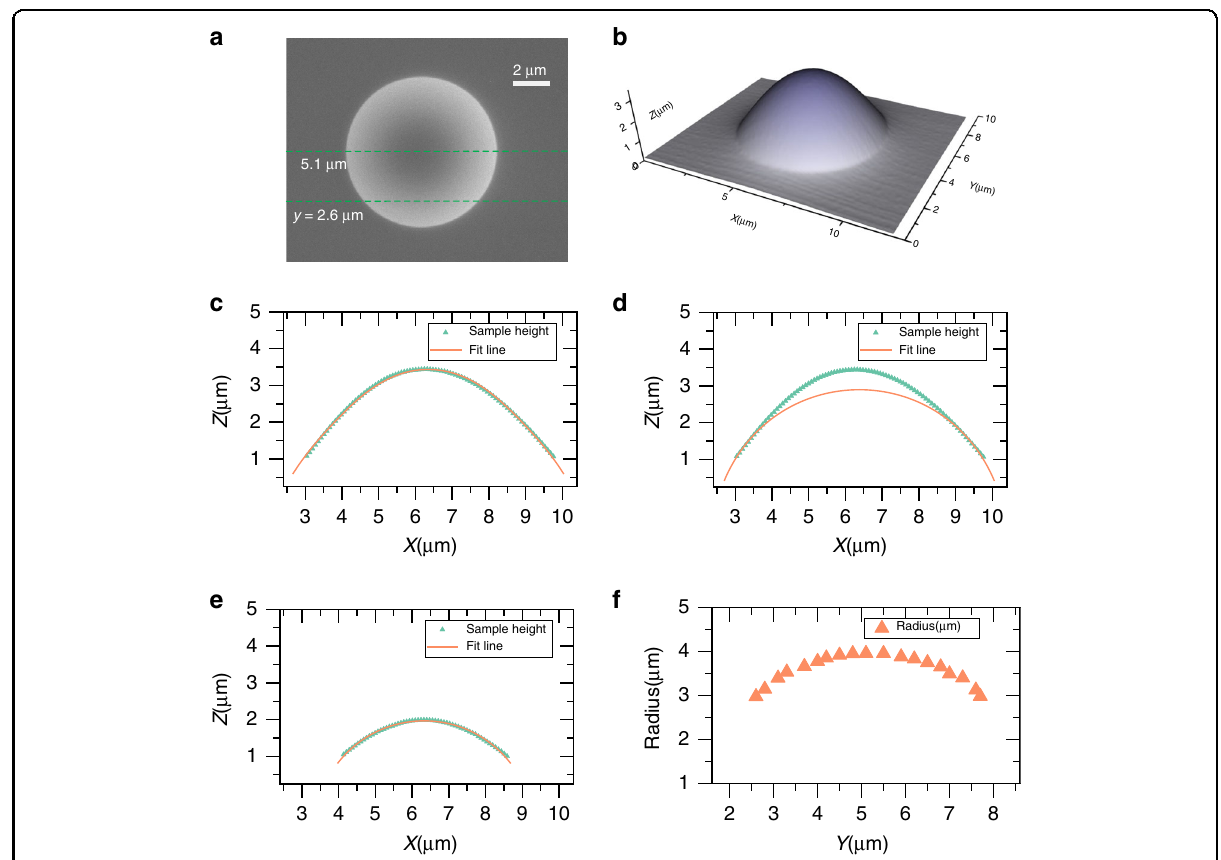
Fig. 5 Structural property of the fabricated curved surface on GaAs substrate and measurement. a top view of the SEM image, in which the green dashed lines label the position of the sections in c – e , in which y = 5.1 μ m corresponds to the diameter of the surface. b The AFM image shown in 3D form. c Fit of the surface of the section at y = 5.1 μ m from the AFM image in b , with a circle graduate changing its radius with the height axis Z. The fi t line follows the equation x (cid:3) x c